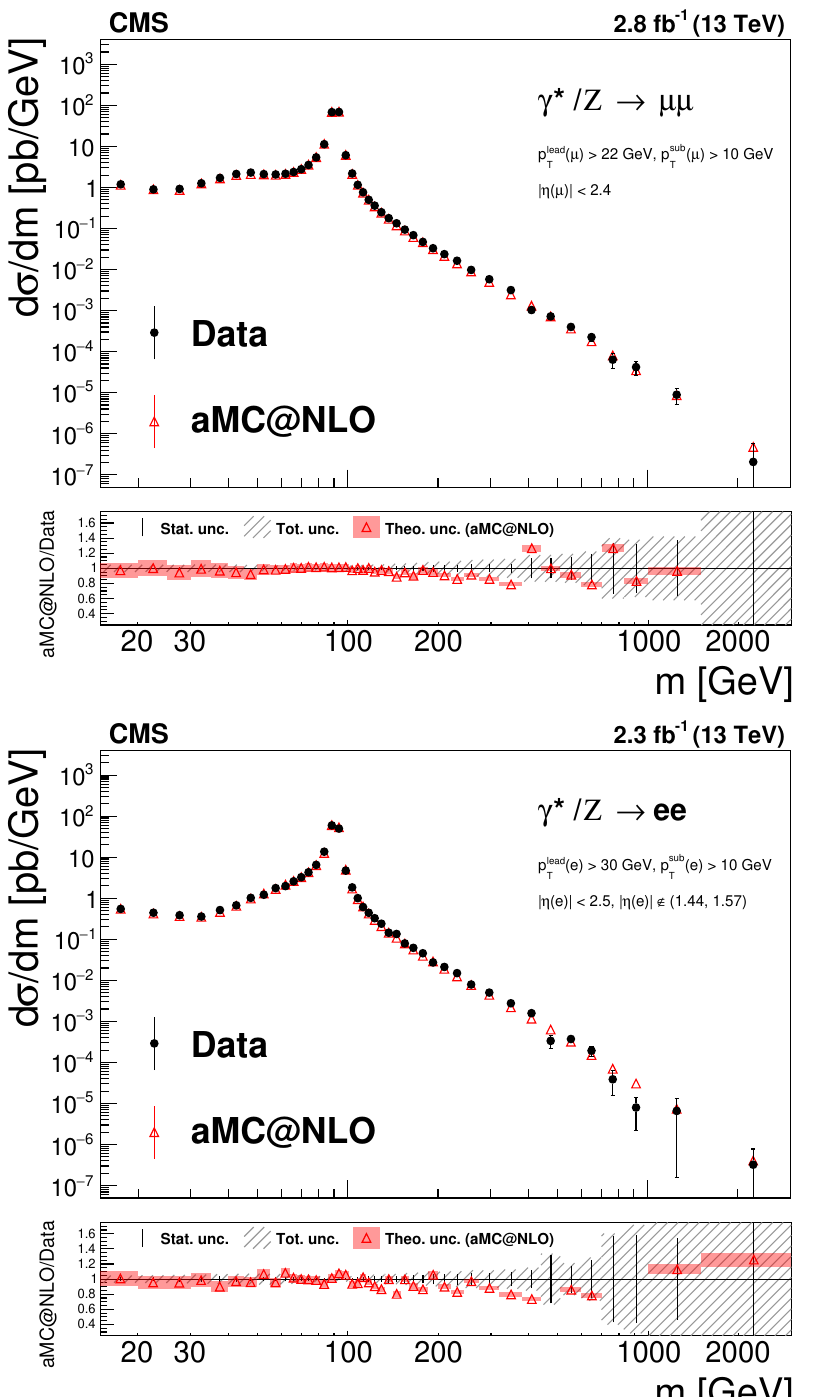
Figure 5 . Comparison between the measured (cid:12)ducial cross section (with no FSR correction ap- plied) and the NLO theoretical prediction of MadGraph 5 a mc@nlo with NNPDF 3.0 in the dimuon (upper) and dielectron (lower) channels. In the bottom panels, the red band represents the theoretical uncertainty and the hatched band represents the total uncertainty, which is the combination of the statistical, systematic, and integrated luminosity components.